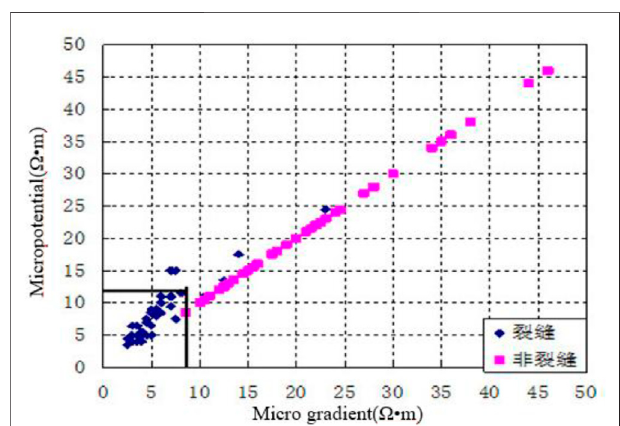
FIGURE4| Intersection chartofbilaterallateralamplitudedifferenceand microelectrode amplitude. FIGURE 5 | Intersection diagram of micro-gradient and